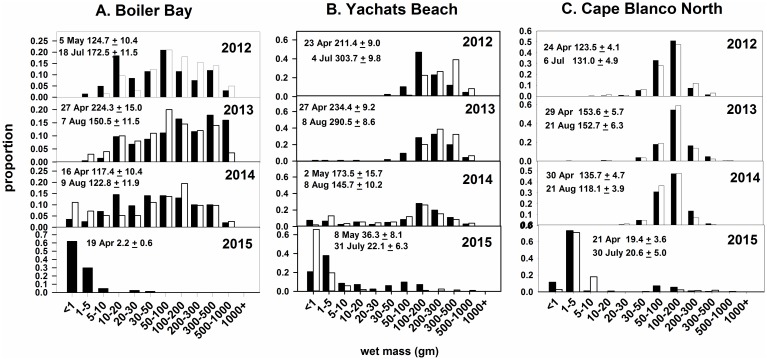
Size frequencies of P. ochraceus from 2012 to 2015 at three representative sites, one per cape.Samples were taken in spring (black bar) and summer (white bar) in each year except for Boiler Bay, where high wave action prevented collection of the summer 2015 sample. Sample size was ~200. Mean wet weight (± 1 SE) is shown for each sample date.